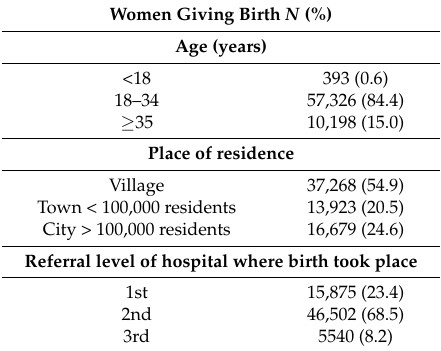
Table 1. Characteristics of women giving birth in the years 2013–2014 in the Malopolska province. Women Giving Birth N (%)